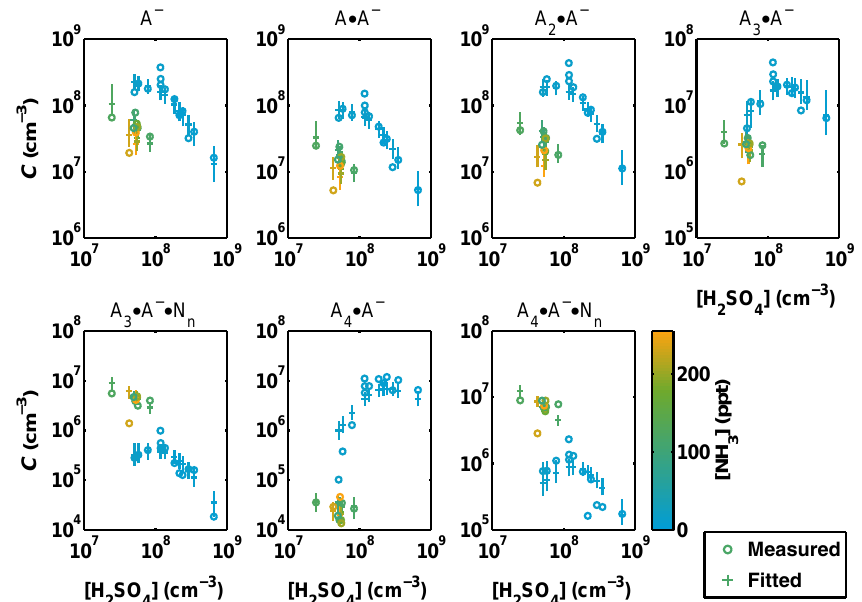
Figure 3. Cluster distributions measured at CLOUD and the corresponding modeled cluster concentrations from an MCMC simulation where evaporation rates, fragmentation probabilities, the ion production rate and the wall loss rate are varied. “A” stands for H 2 SO 4 , “A − ” for HSO − and “N” for NH 3 . 4